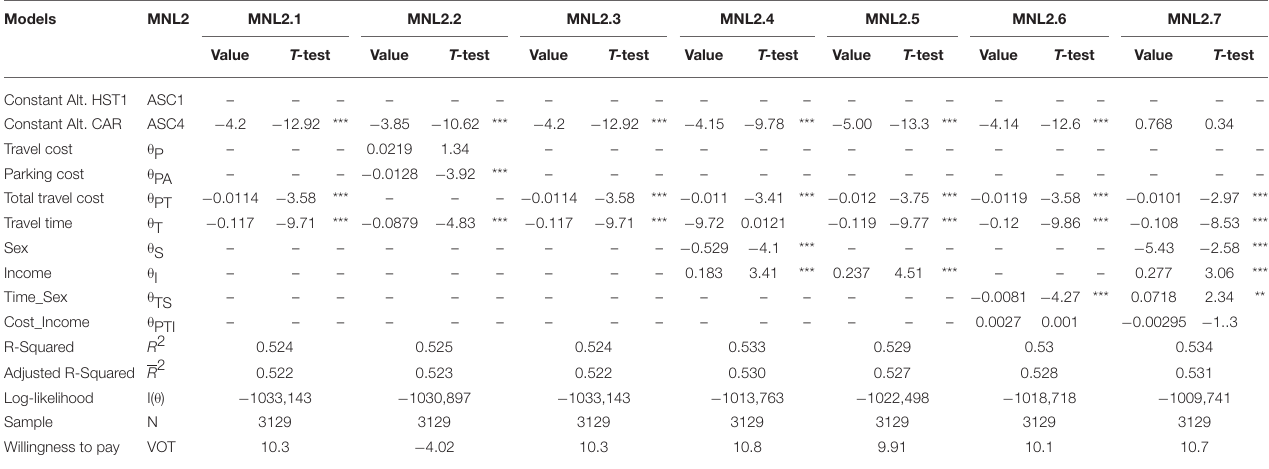
TABLE 2 | Estimated binomial model results MNL2 (HST2-CAR).